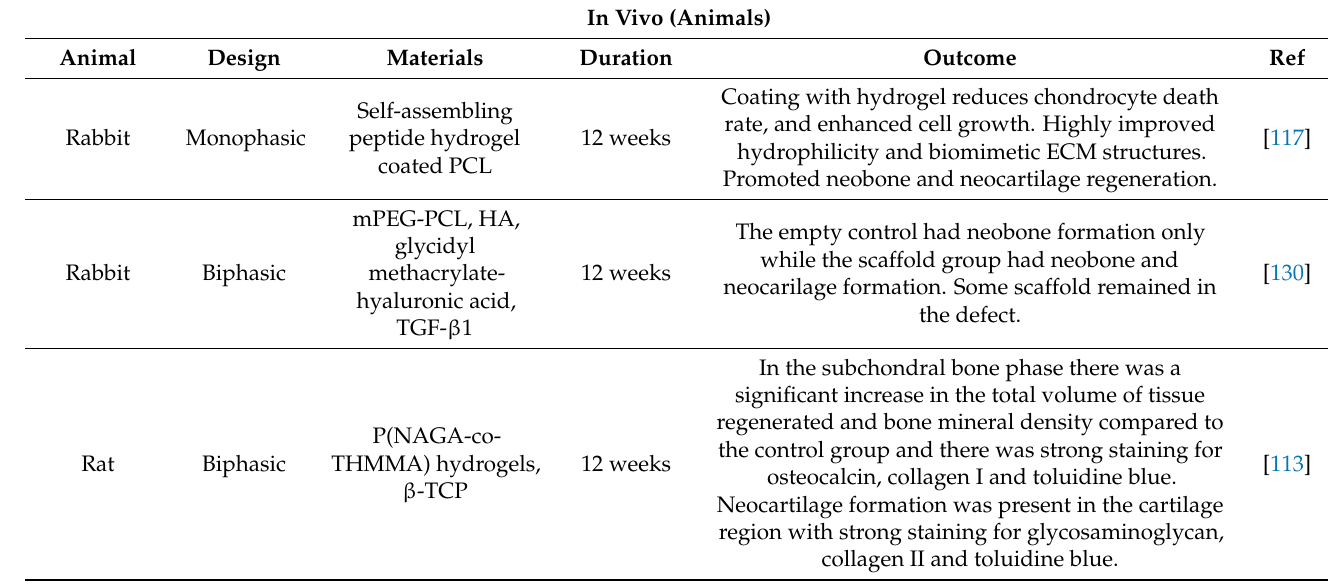
Table 4. In vivo animals models for OC